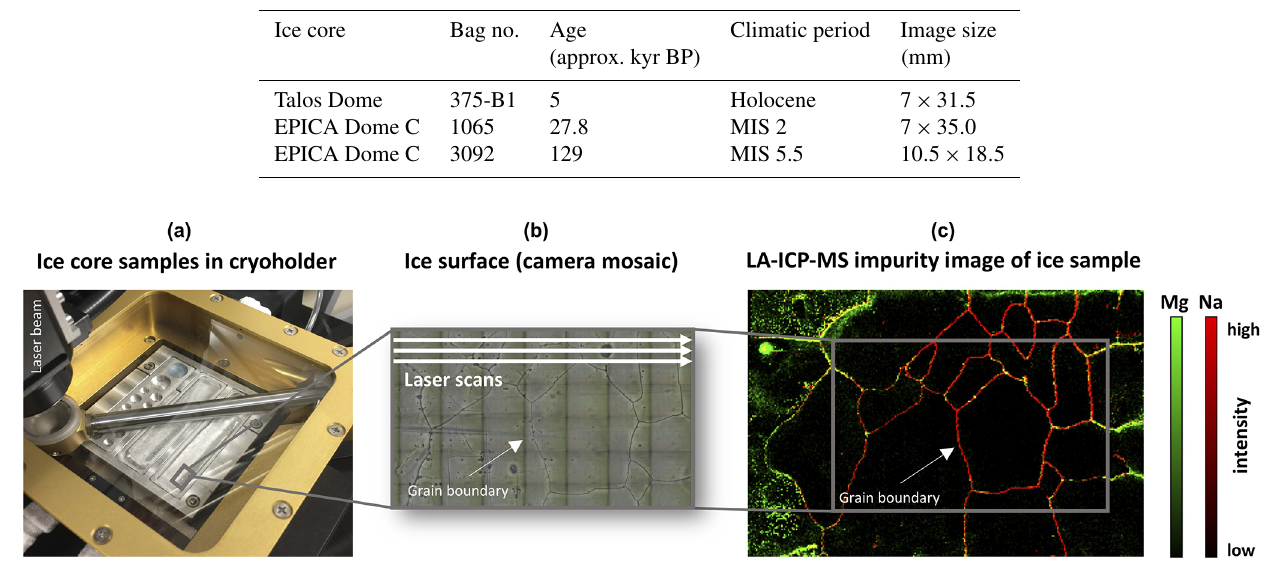
Table 1. Samples from Antarctic ice cores analyzed by LA-ICP-MS impurity imaging.